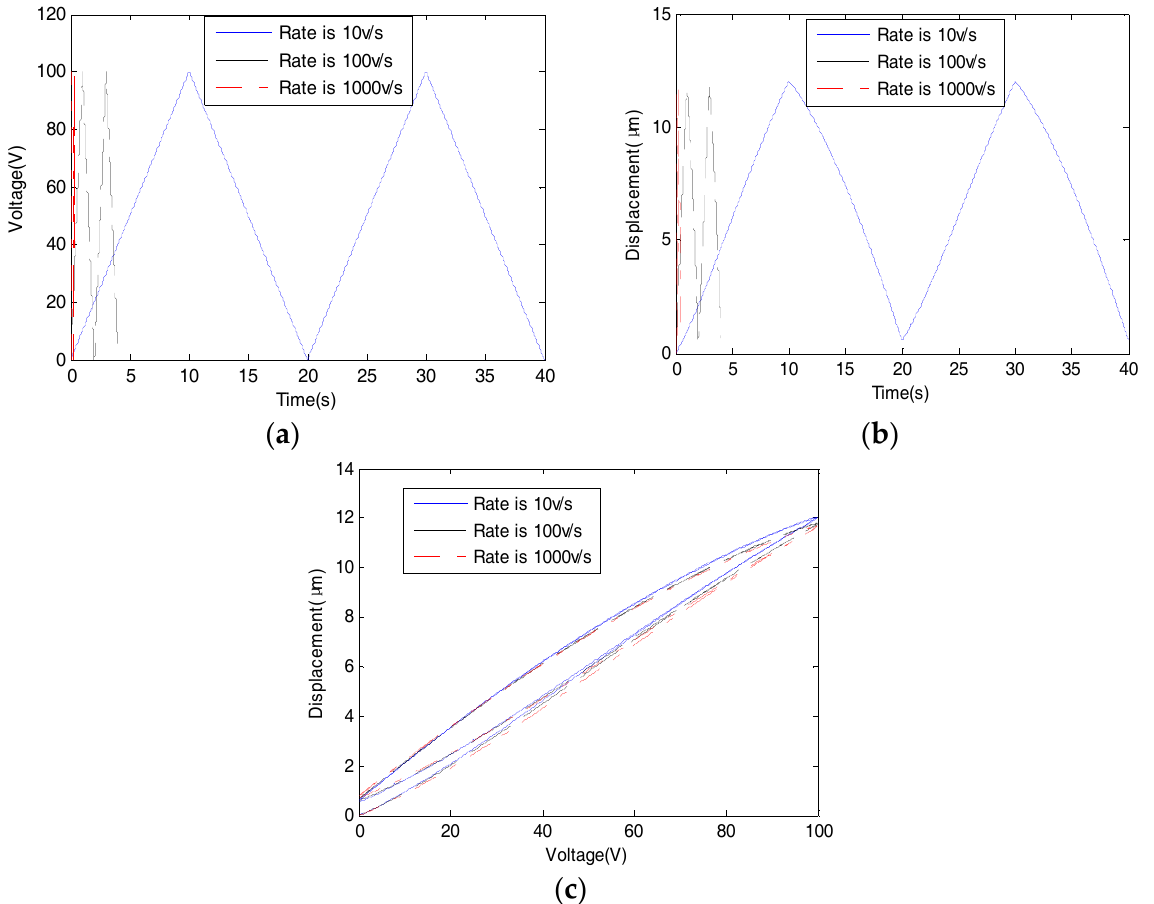
Figure 13. The rate-dependence of hysteresis in PZA ( a ) input voltage signals with different rates; ( b ) output displacement; ( c ) hysteresis loops. Micromachines 2015 , 6 , page–page